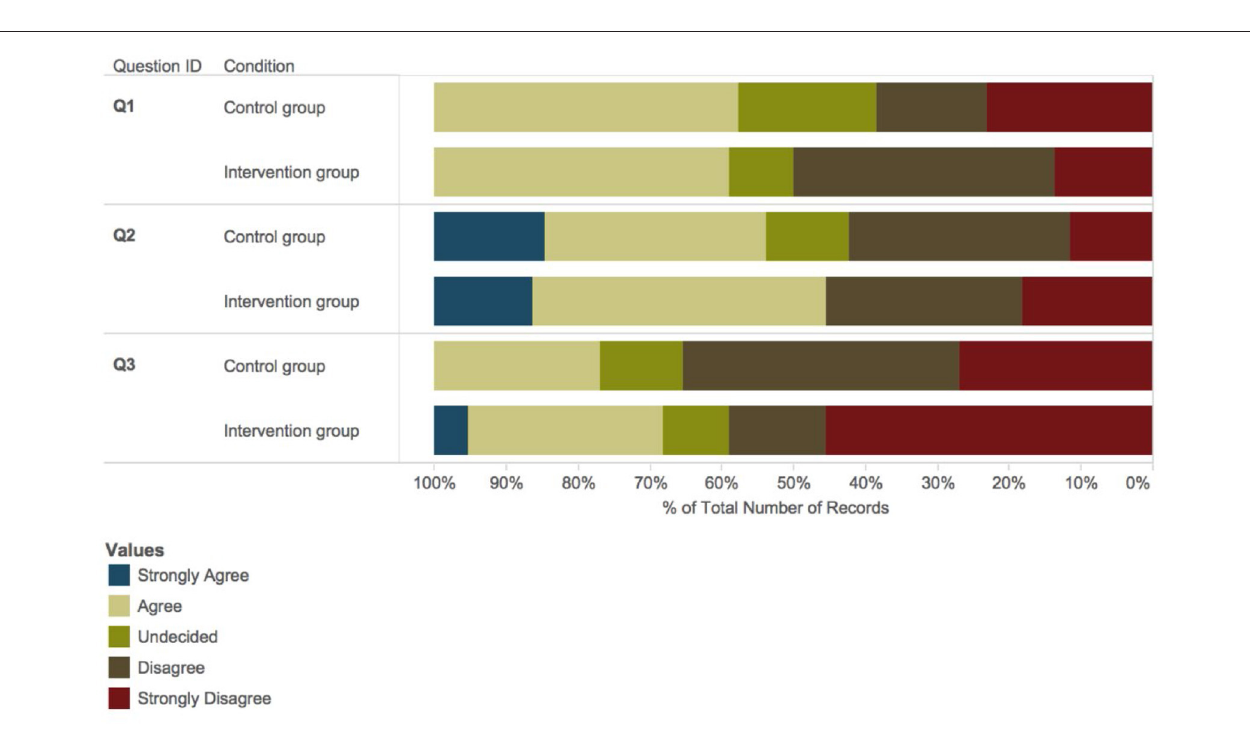
FIGURE 7 | The level of agreement in intervention and control group for food waste behaviors. Q1: “I tend to overbuy food that gets wasted,” Q2: “I tend to throw out food because of passing expiry dates,” and Q3: “I commonly throw away leftovers that I forgot I have.” [Q1 = S3; Q2 = S4; and Q3 = S5, all in Table 1